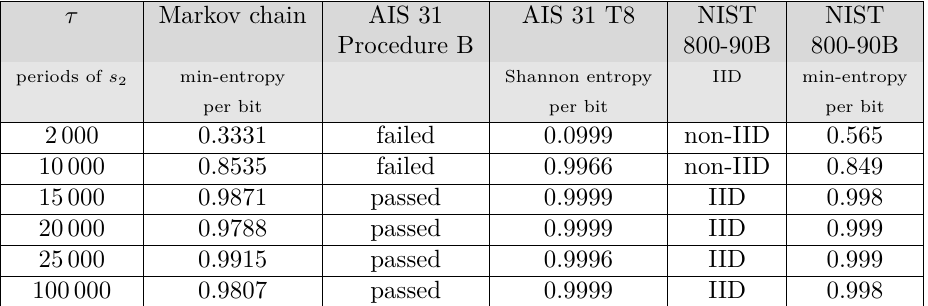
Table 9: Entropy estimation using high order Markov chains, AIS 31 and NIST 800-90B tests, when two internal STRs and the least significant bits of counter values were used. Dependencies are modeled using 8 th order Markov chains.